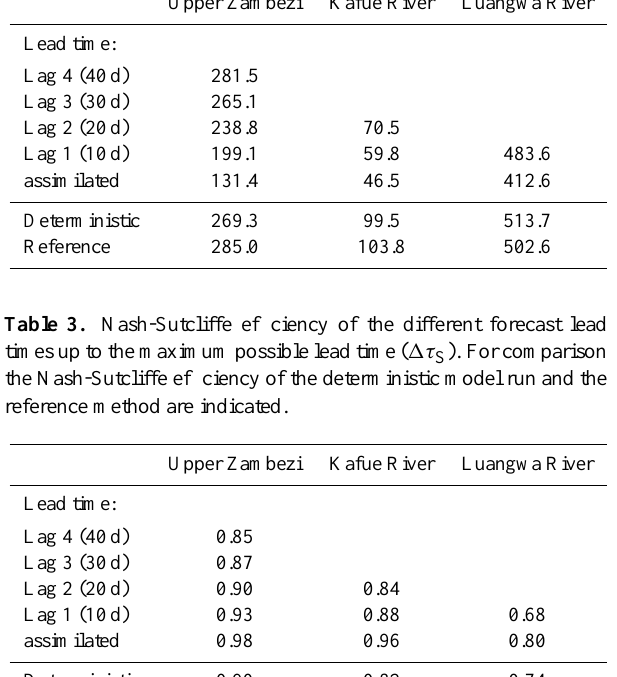
Fig. 6a. Absolute (solid line) and relative (dashed line) forecast error for the Upper Zambezi watershed for the different forecast periods and the assimilation step.